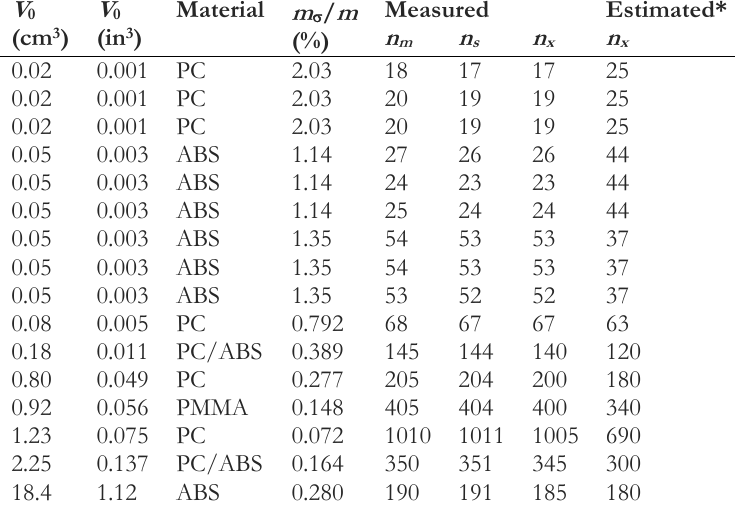
Table 2. Data from counting experiments for parts of various nominal volumes (V 0 ) and compositions.